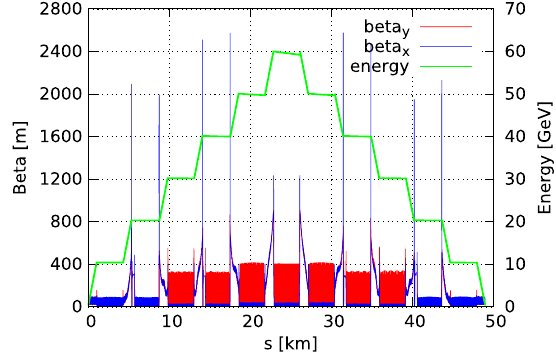
FIG. 9. Beta functions and energy profile obtained following a bunch throughout the entire LHeC lattice.